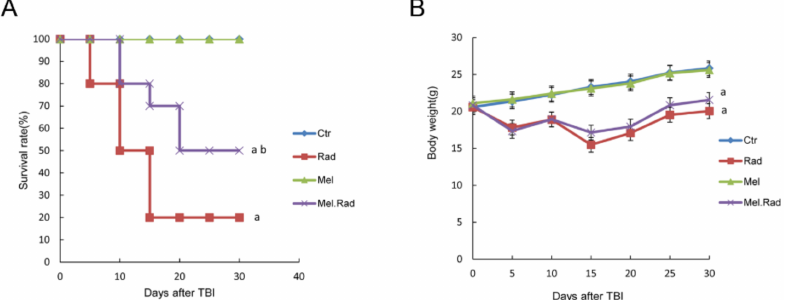
Figure 1. Effects of melatonin on the 30-day survival rate of mice following TBI. Mice were treated with melatonin (10 mg/kg) daily for 5 consecutive days by intraperitoneal injection before exposure to a dose of 7.2 Gy radiation and then examined for 30 days. A group of sham-irradiated control mice was regarded as a control. ( A ) The number of surviving mice was counted and the survival curve was plotted. ( B ) The body weight of surviving mice was detected. Data are represented as mean ± SD, n = 10 mice/group. a p < 0.05 vs. Ctr; b p < 0.05 vs.